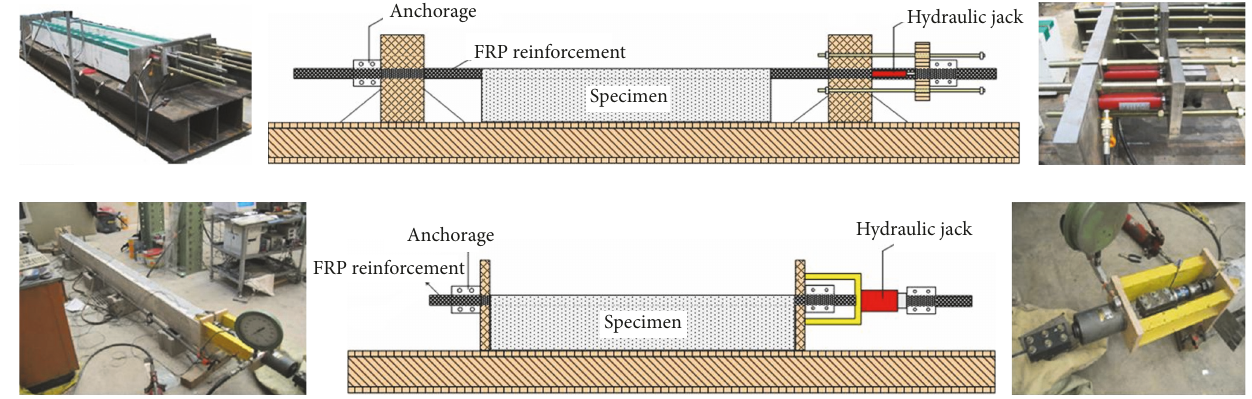
Figure 1: The existing prestressing system.